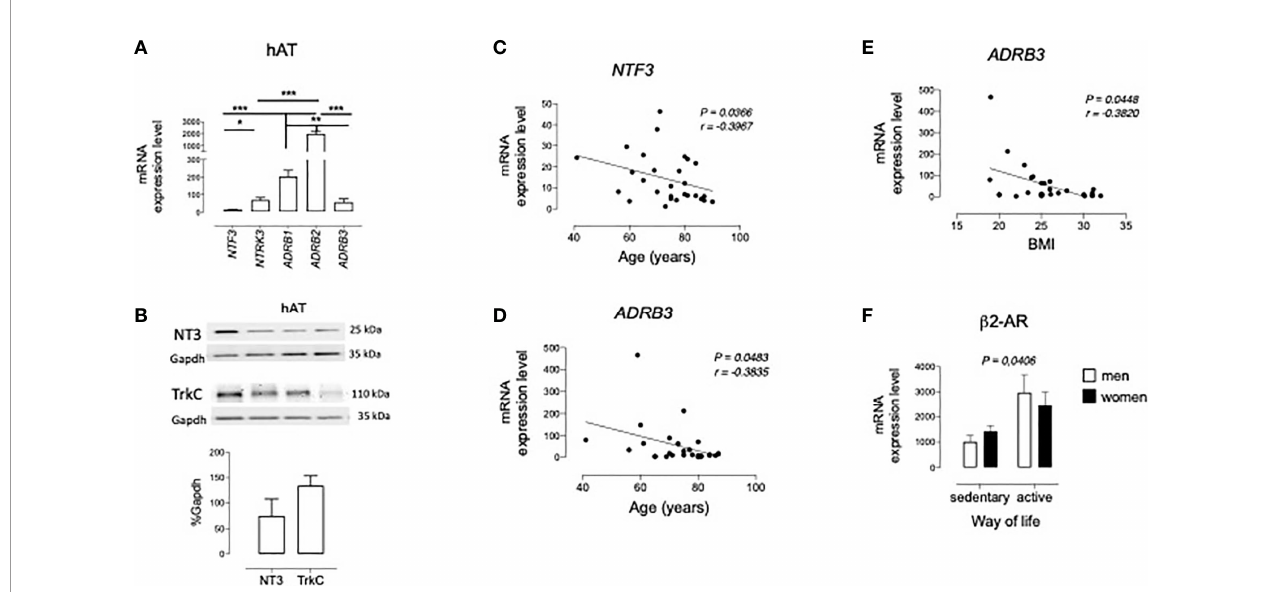
FIGURE 1 | Expression of NT3 and TrkC in human adipose tissues. (A) mRNA levels of NT3 ( NTF3 ), TrkC ( NTRK3 ), and the three b -adrenoceptor subtypes ( ADRB1, ADRB2 , and ADRB3 ) in human retroperitoneal adipose tissue (hAT, n = 28) * P < 0.05, ** P < 0.01, *** P < 0.001, Kruskal-Wallis test followed by Dunns multiple comparison test (B) representative immunoblots of NT3 and TrkC and quanti fi cation of the protein expression in hAT (n = 4), using GAPDH as reference. Graphical representation of the correlation observed between the mRNA levels of NTF3 and age (C) , and ADRB3 and age (D) or body mass index (E) . Signi fi cant Spearman correlation (P < 0.05) is represented as a continuous line. (F) mRNA levels of ADRB2 in adipose tissue from sedentary vs active men and women. P < 0.05 sedentary vs active way of life, two way ANOVA test. Values of mRNA are expressed as 2 - D Ct x10 4 using GAPDH as a housekeeping gene and represent the mean ± SEM in bar diagrams, or individual values in graphical